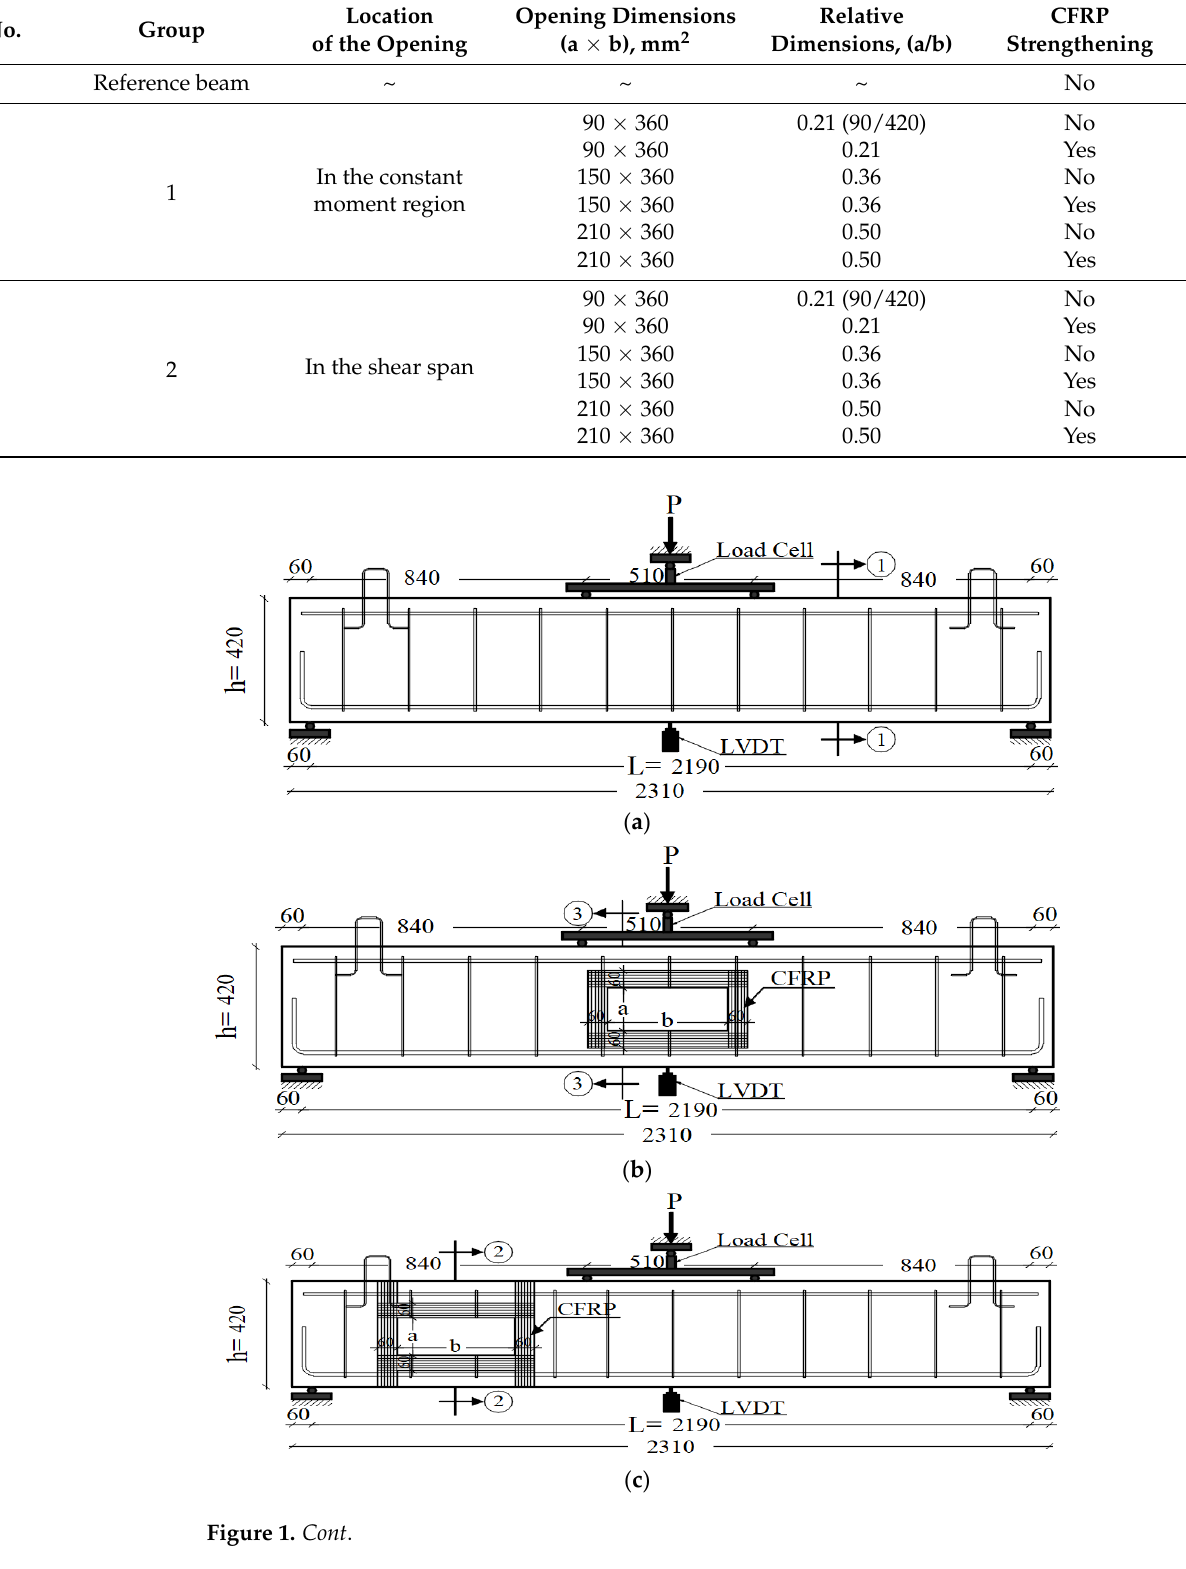
Table 1. Opening Dimensions for Group No. 1 and Group No. 2. Beam No.